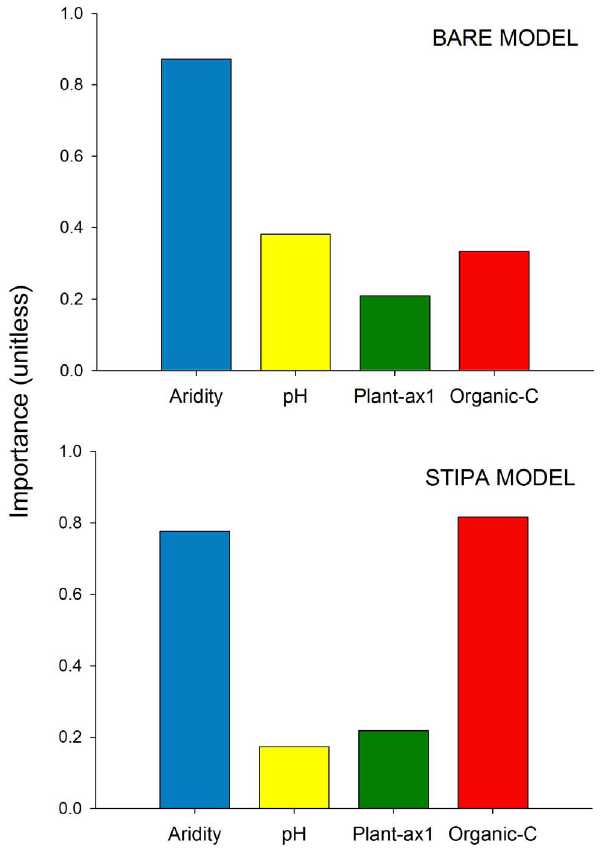
Figure 2. Relative importance of aridity, pH, organic C, and plant-ax1 (first component of a PCA including the cover of bare and plant microsites, average plant patch interdistance, area of plant patches and number of plant patches per 10 m of transect) variables as drivers of variations in N availability. Results are shown for: i) bare ground microsites, and ii) Stipa tenacissima microsites. The height of each bar is the sum of the Akaike weights of all models that included the predictor of interest, taking into account the number of models in which each predictor appears.